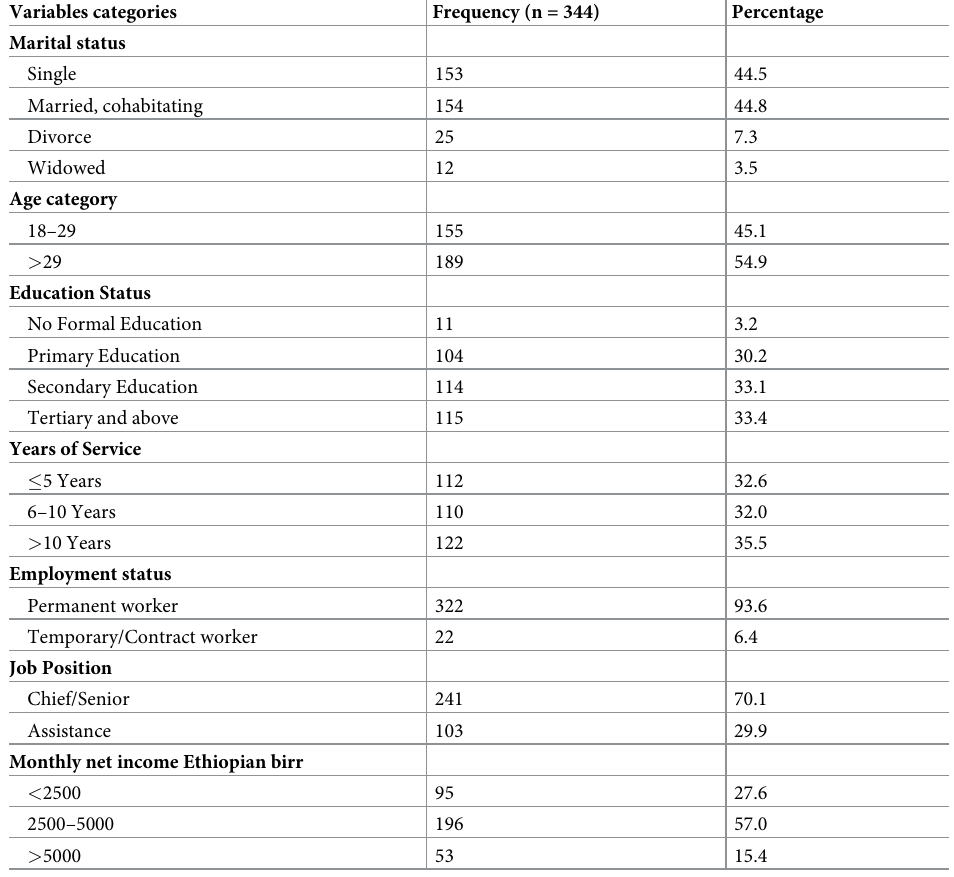
Table 1. Socio-demographic characteristics of vehicle repair workers in Hawassa city, Ethiopia, 2019. Variables